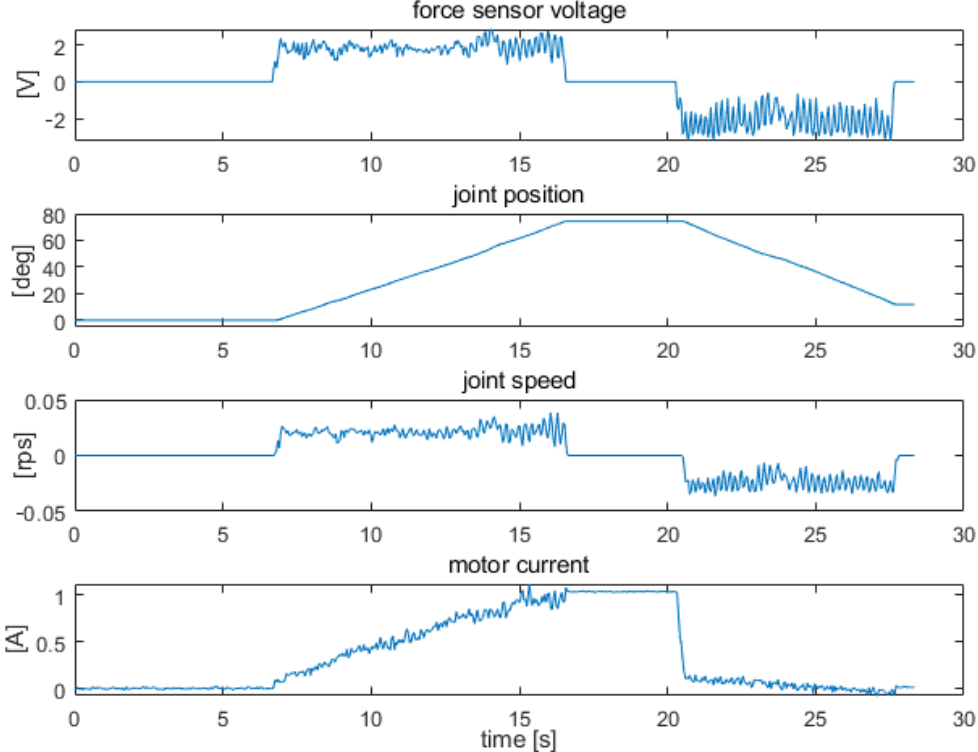
Figure 11. Signal waveforms from force, position, speed, and supply current sensors for elbow joint drive under uneven force on the sensors.